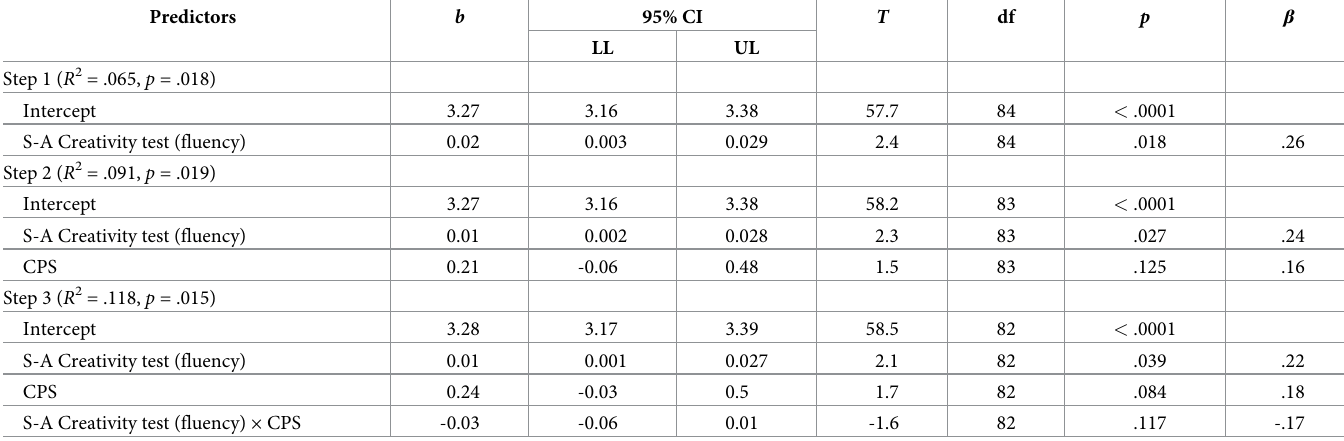
Table 3. Results of multiple regression analysis in the effect of fluency with creative production score as the objective variable.